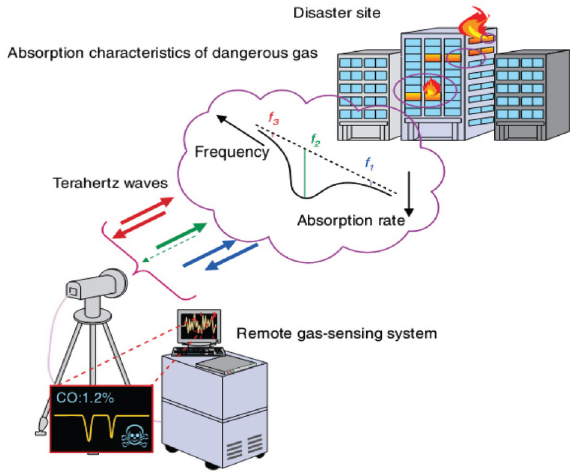
Figure 4: Operating principle of remote gas-sensing system based on THz spectroscopy.